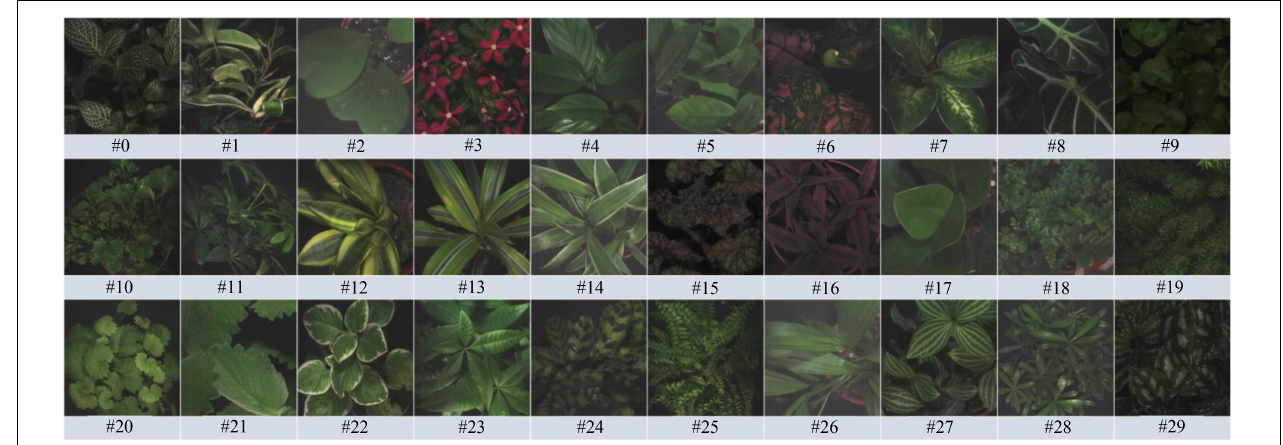
FIGURE 1 | The RGB sample images of the 30 plant species.